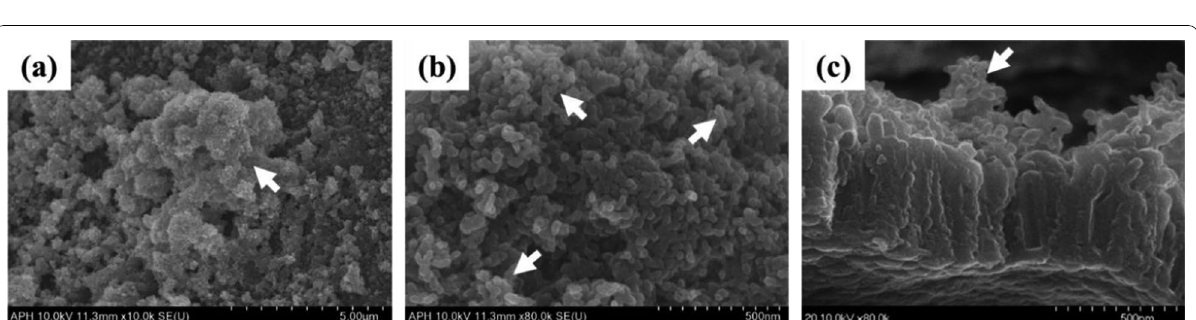
Fig. 2 FE‑SEM images of the surface of a Ti–6Al–4V ELI alloy plate specimen of the APH group. a Top view with 10 k with 80 k magnification, c Cross‑sectional view with 80 k ×